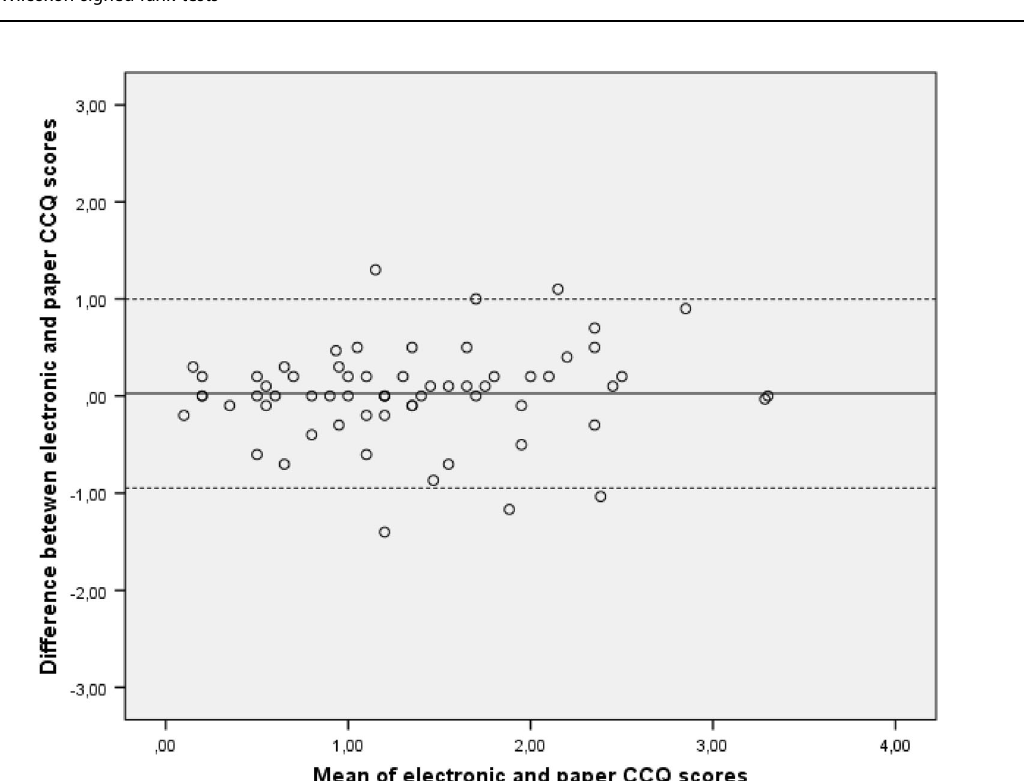
Fig. 2 Bland – Altman plot showing the relationship between the electronic and paper version of the CCQ. The dashed lines represent the limits of agreement